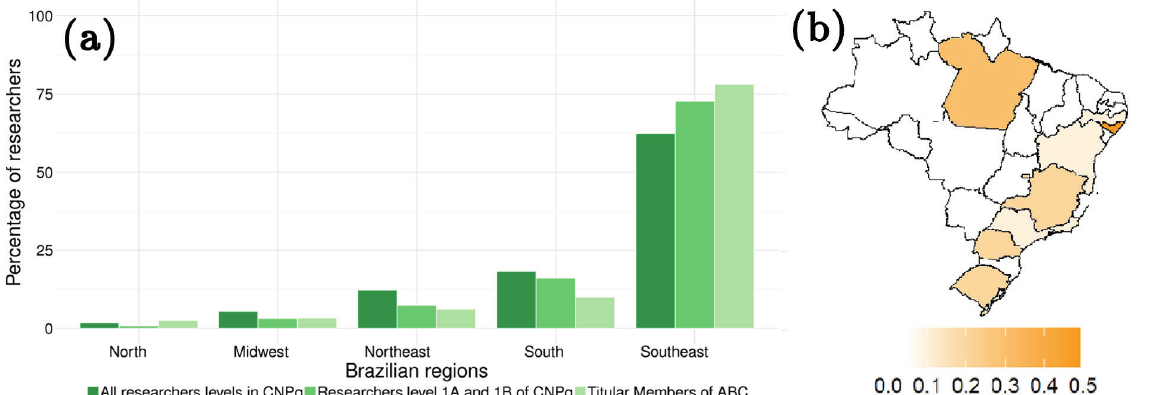
Figure 1 - a) Distribution of the total number of CNPq PQ-researchers, 1A and 1B CNPq PQ-researchers and ABC titular members per Brazilian geographic region. Distribution of the percentage of CNPq PQ-researchers, 1A and 1B CNPq PQ-researchers and ABC titular members per Brazilian geographic region. The total number of individuals in each category is 10311 as PQ researchers, where 1818 are in the levels 1A and 1B. The total number of titular members of ABC who have a Brazilian address is 490. b) Map of the quotient of the number of titular female researchers divided by the total number of titular members by state. The color code is shown in the